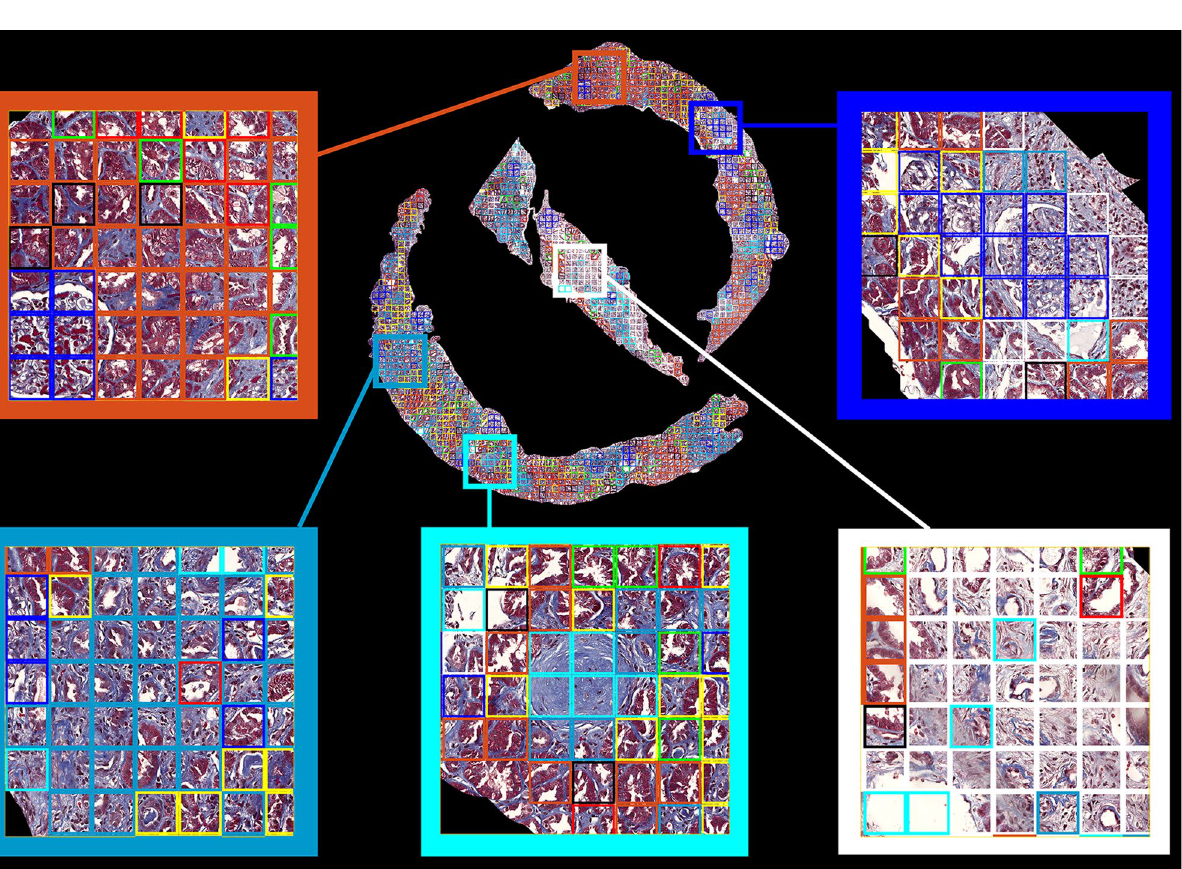
Figure 7. An example of cortex trichrome stained images with color-coded patches and zoomed